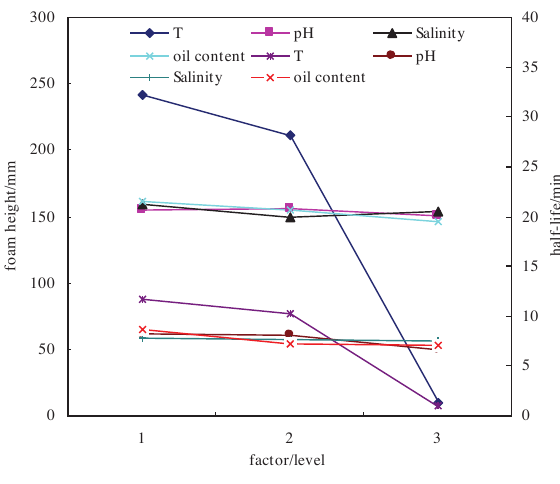
Figure 1: NPL-10 trend chart of factors at three different levels. Level 1 = 220 °C , level 2 = 260 °C; level 3 = 300 °C. Top lines (dark blue, light blue, black and pink): effect on foam height. Bottom lines (violet, red, brown, green): effect on foam half-life.